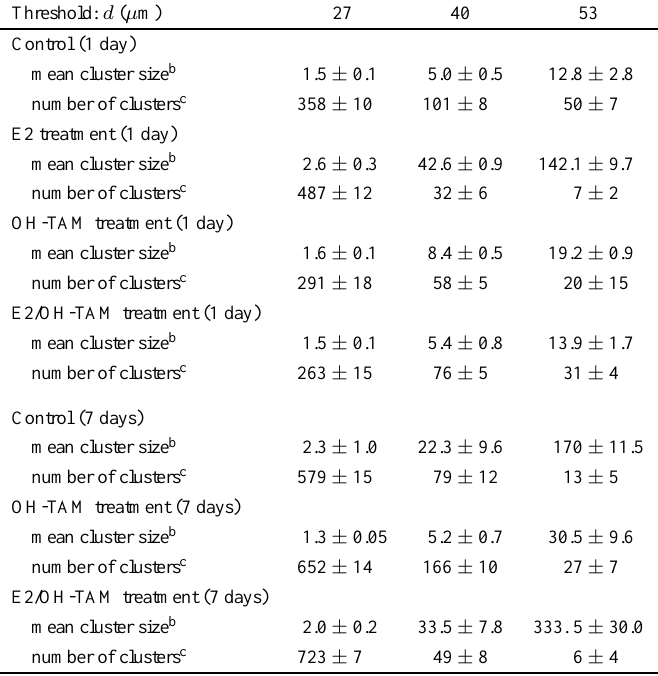
Results of the cluster analysis on the different treated samples